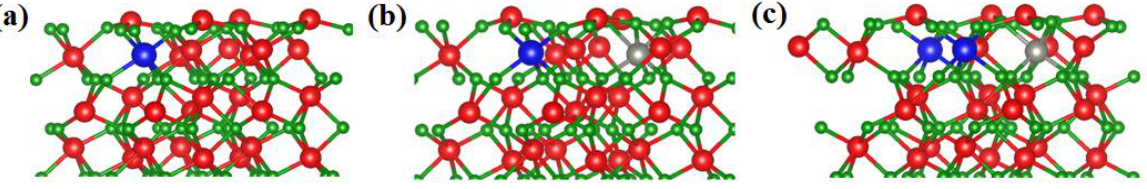
Figure 1. The relaxed mono and bimetallic doped {0001) surfaces: ( a ) mono X doped, ( b ) bimetallic (Zn, X ) doped, and ( c ) bimetallic (Zn, 2 X ) doped. Colour scheme: red (big spheres) and green (small spheres) denote Fe and O atoms, respectively; blue and grey (big sphere) represent X and Zn atoms, where ( X = Ti or Zn).